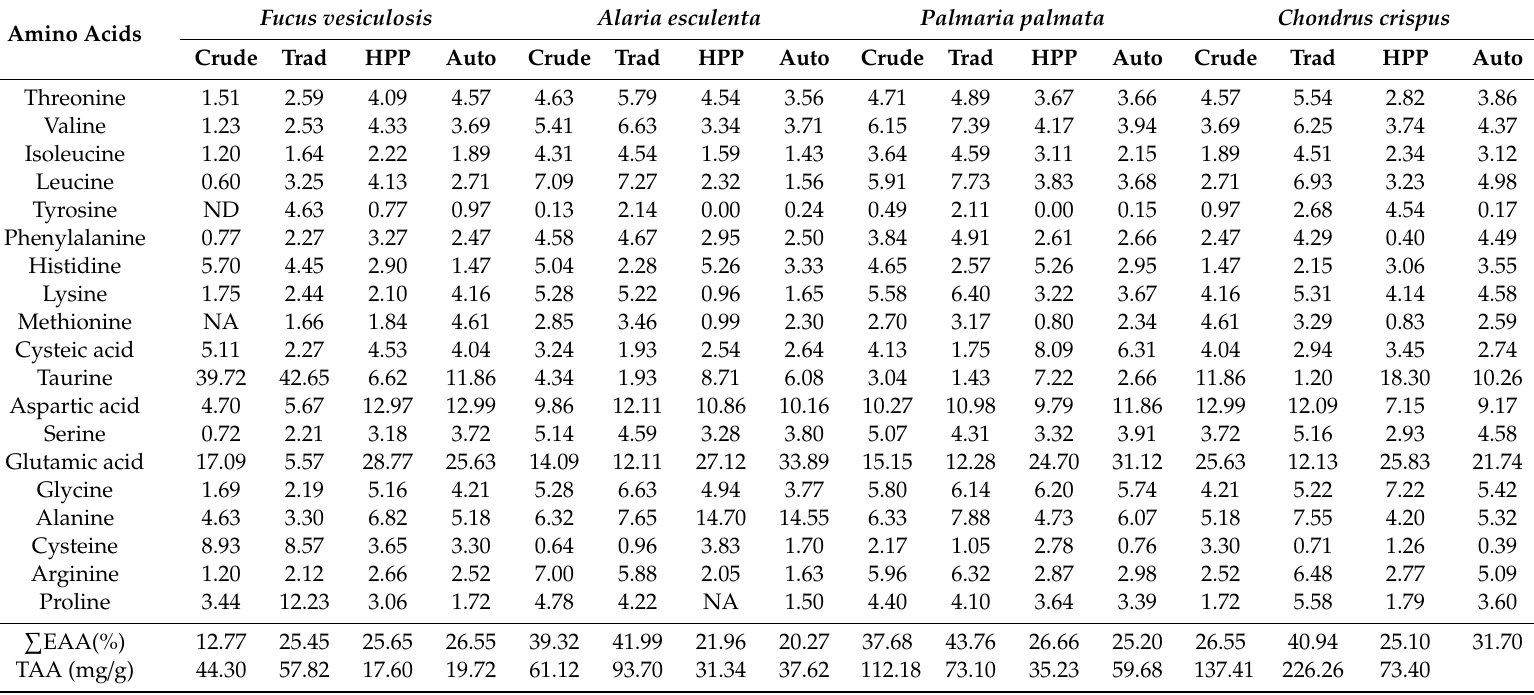
Table 2. Amino acid profile of the crude macroalgae and macroalgal derived protein extracts (percentage of the Total amino acids), N = 1. Fucus Amino Acids